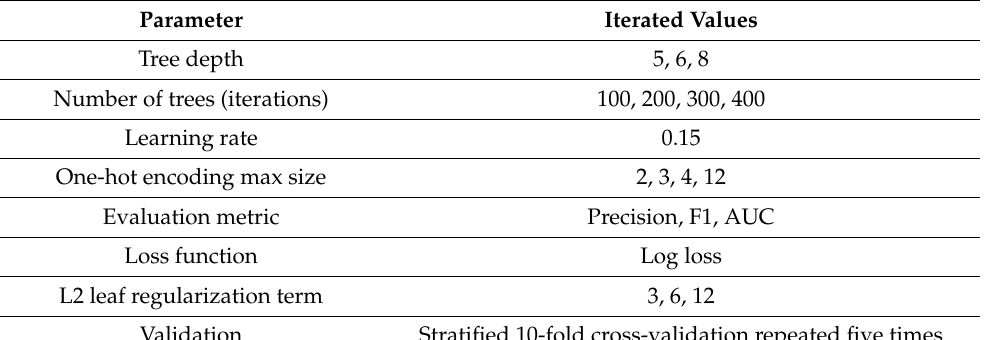
Table 2. Hyperparameter